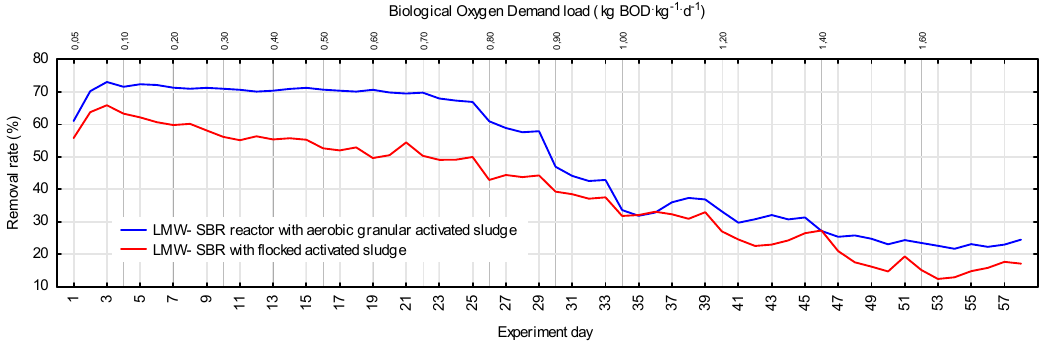
Figure 2. Sum of low molecular weight polycyclic aromatic hydrocarbons ( Σ LMW) removal rate in sequencing bath reactor (SBR) aerobic phase.